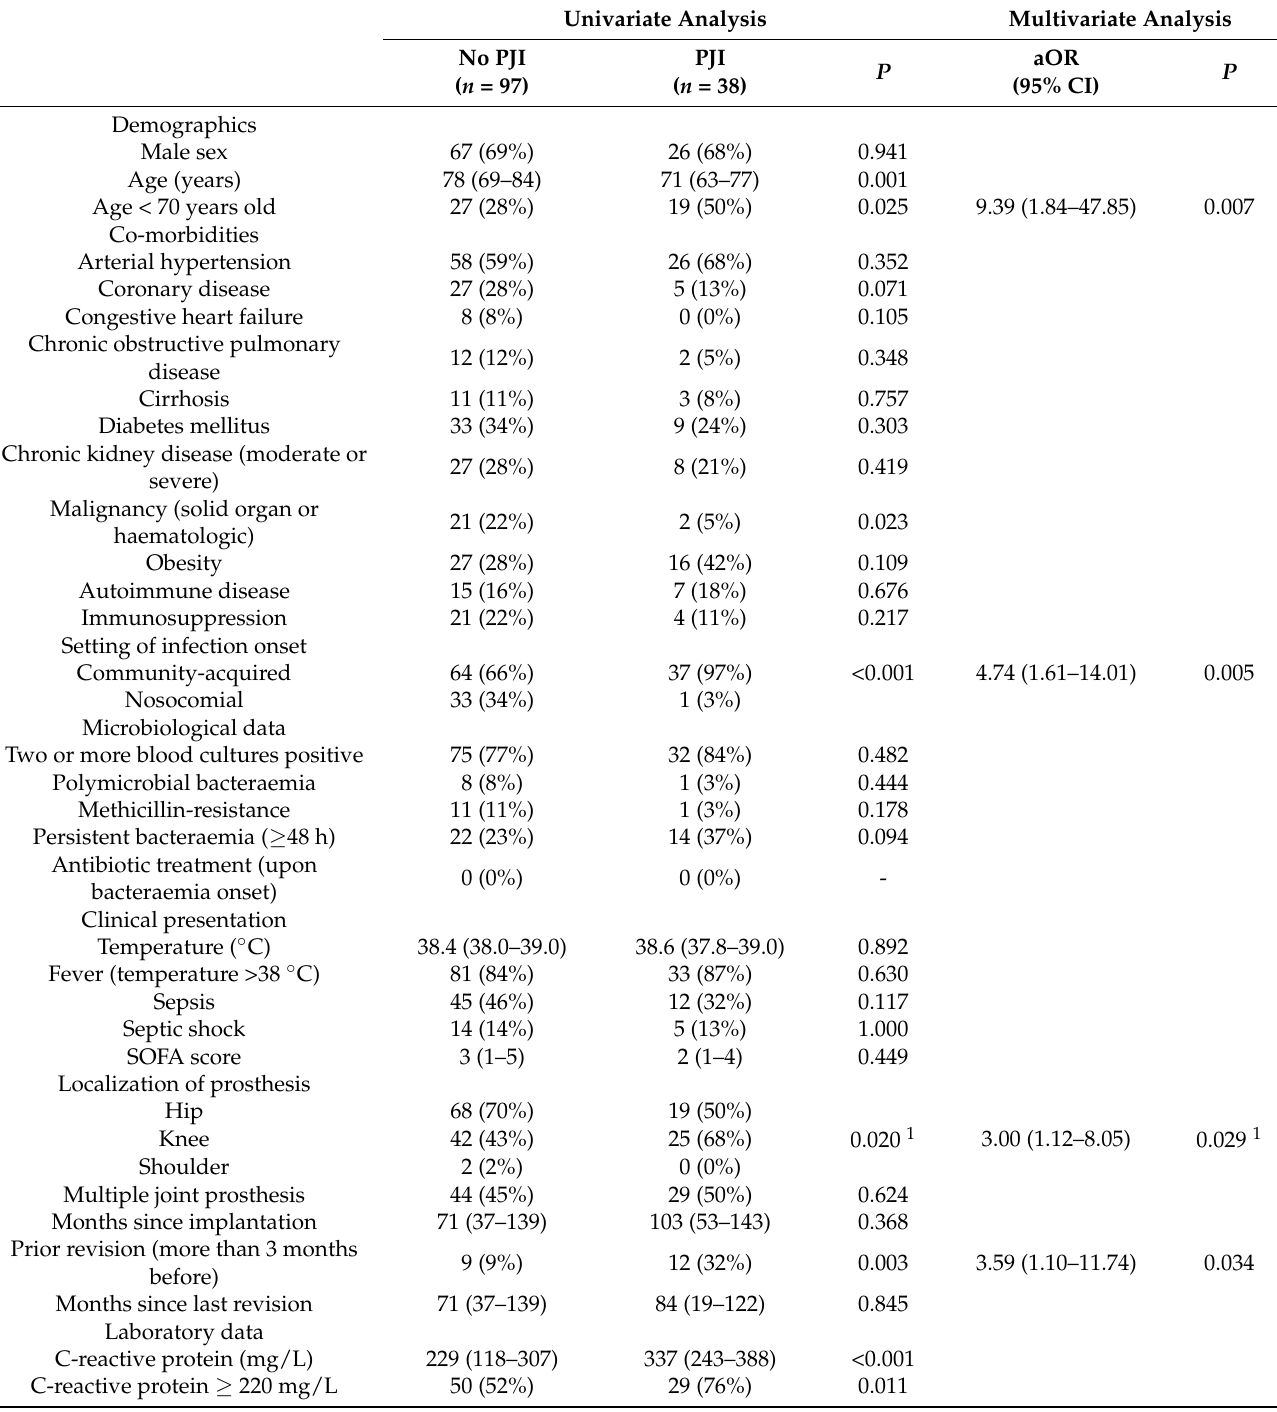
Table 2. Characteristics of patients with S. aureus bacteraemia in the presence of prosthetic joint according to the presence or absence of prosthetic joint infection